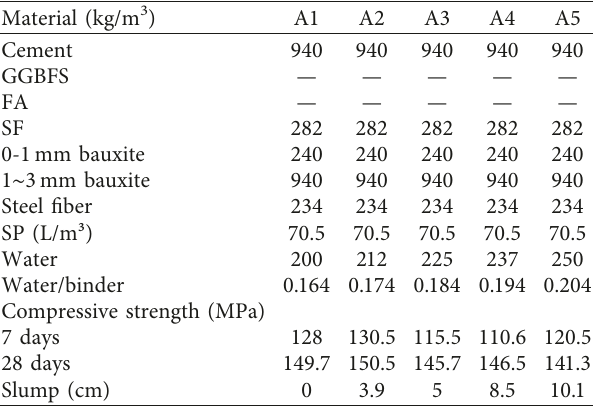
Table 2: Composition of the mixtures and the test